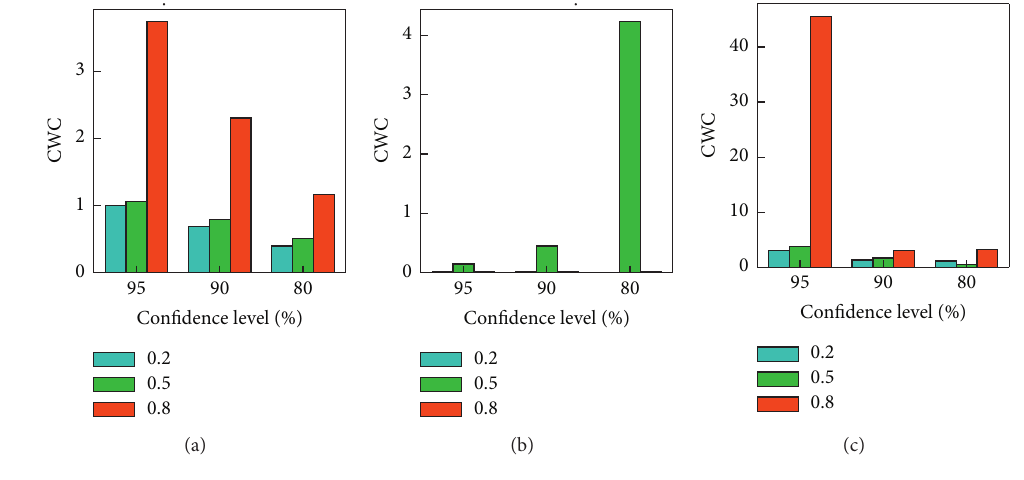
Figure 10: Histogram of CWC for all prediction models. Table 5: Comparison of PIs obtained using SC and SC-KDE